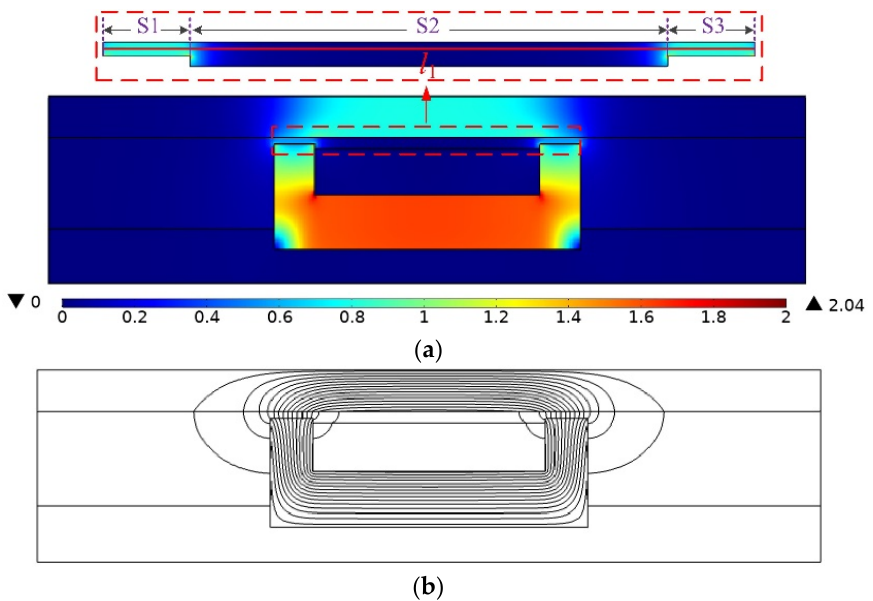
Figure 7. Magnetic field distribution of the MR damper. ( a ) Contour of Magnetic flux density. ( b ) distribution of magnetic flux lines.